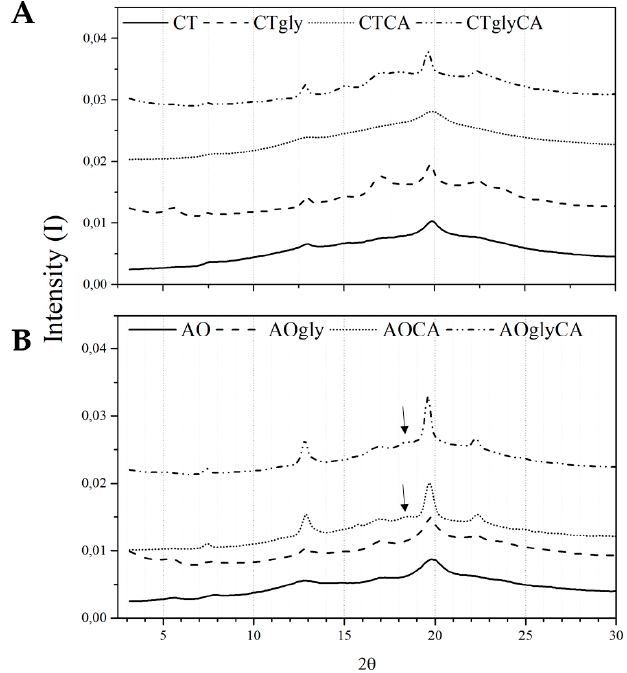
Figure 3. Wide angle X-ray scattering (WAXS) diffractograms of extruded samples showing the effect of glycerol and CA cross-linking on crystal formation: ( A ) Control starch; ( B ) AO starch. Arrows highlight the A-type polymorph.